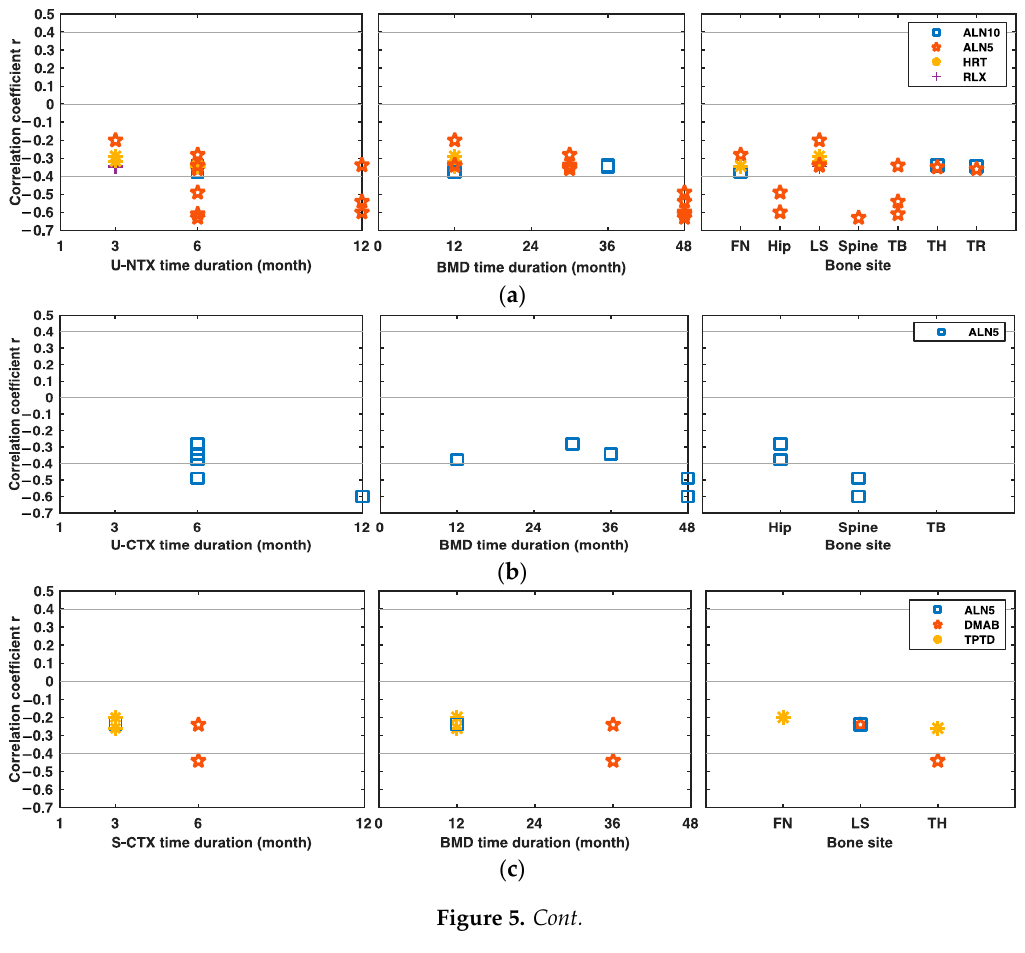
Figure 4. Significant correlations between the changes in BFMs and BMD at di ff erent bone sites under di ff erent drug interventions over time. ( a ) Correlations between the changes in bone ALP and BMD from baseline at di ff erent bone sites under di ff erent drug interventions over time. ( b ) Correlations between the changes in osteocalcin (OC) and BMD under di ff erent drug interventions over time. ( c ) Correlations between the changes in procollagen type I N propeptide (PINP) and BMD under di ff erent drug interventions over time. ( d ) Correlations between the changes in PICP and BMD under di ff erent drug interventions over time. ALN alendronate, ALN5 5 mg / d ALN, ALN10 10 mg / d ALN, ALN10 + HRT, combination of 10 mg / d ALN and HRT, BFM bone formation marker, CCT calcitonin, DMAB denosumab, HRT hormone replacement therapy, RLX raloxifene, TPTD teriparatide, FN femoral neck, LS lumbar spine, TB total body, TH total hip, TR trochanter.